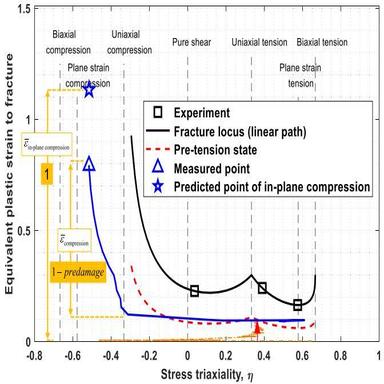
Inverse calculation of in-plane compressive fracture point.